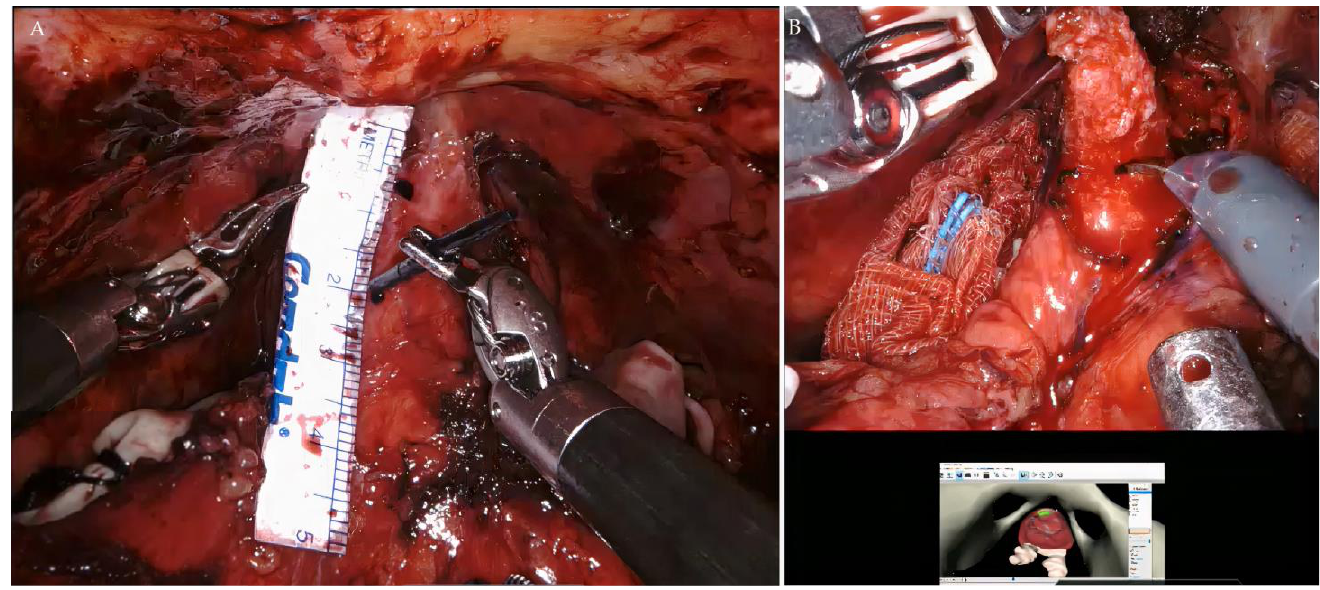
Figure 4. ( A ) Marking the area to be excised after exposing the prostate. ( B ) Demonstrating the reconstructed personal 3D image onto the console monitor while performing the RAPP.